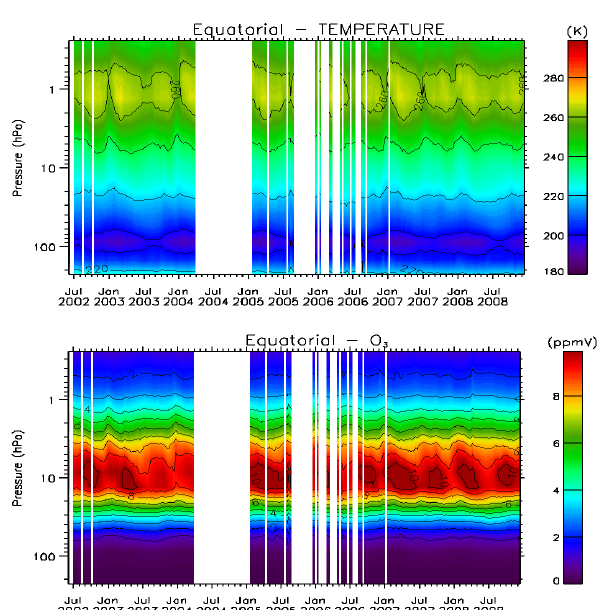
Fig. 13. Time series of 10-days means of temperature and ozone in the Antarctic region (65 ◦ S–90 ◦ S).